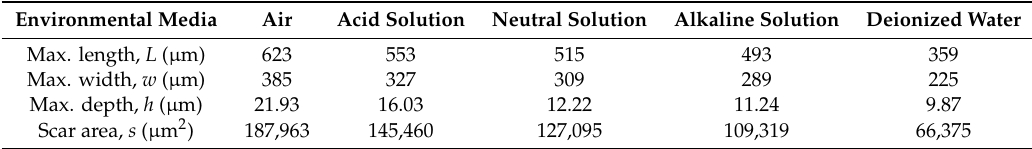
Figure 3. Three-dimensional white light interference surface morphology of wear scar of cyclic loaded wire in the case of acid solution. Table 4. Sizes of wear scars of cyclic loaded wires in di ff erent environmental